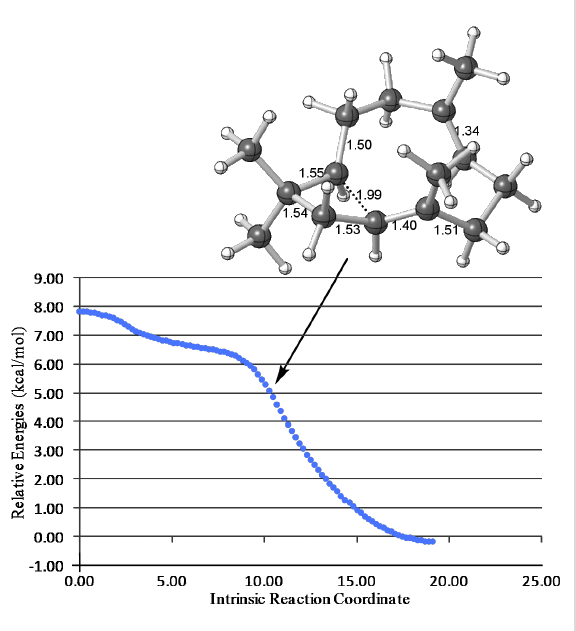
Figure 4: IRC from TS-AC toward C . Relative energies were calcu- lated at the B3LYP/6-31+G(d,p) level.